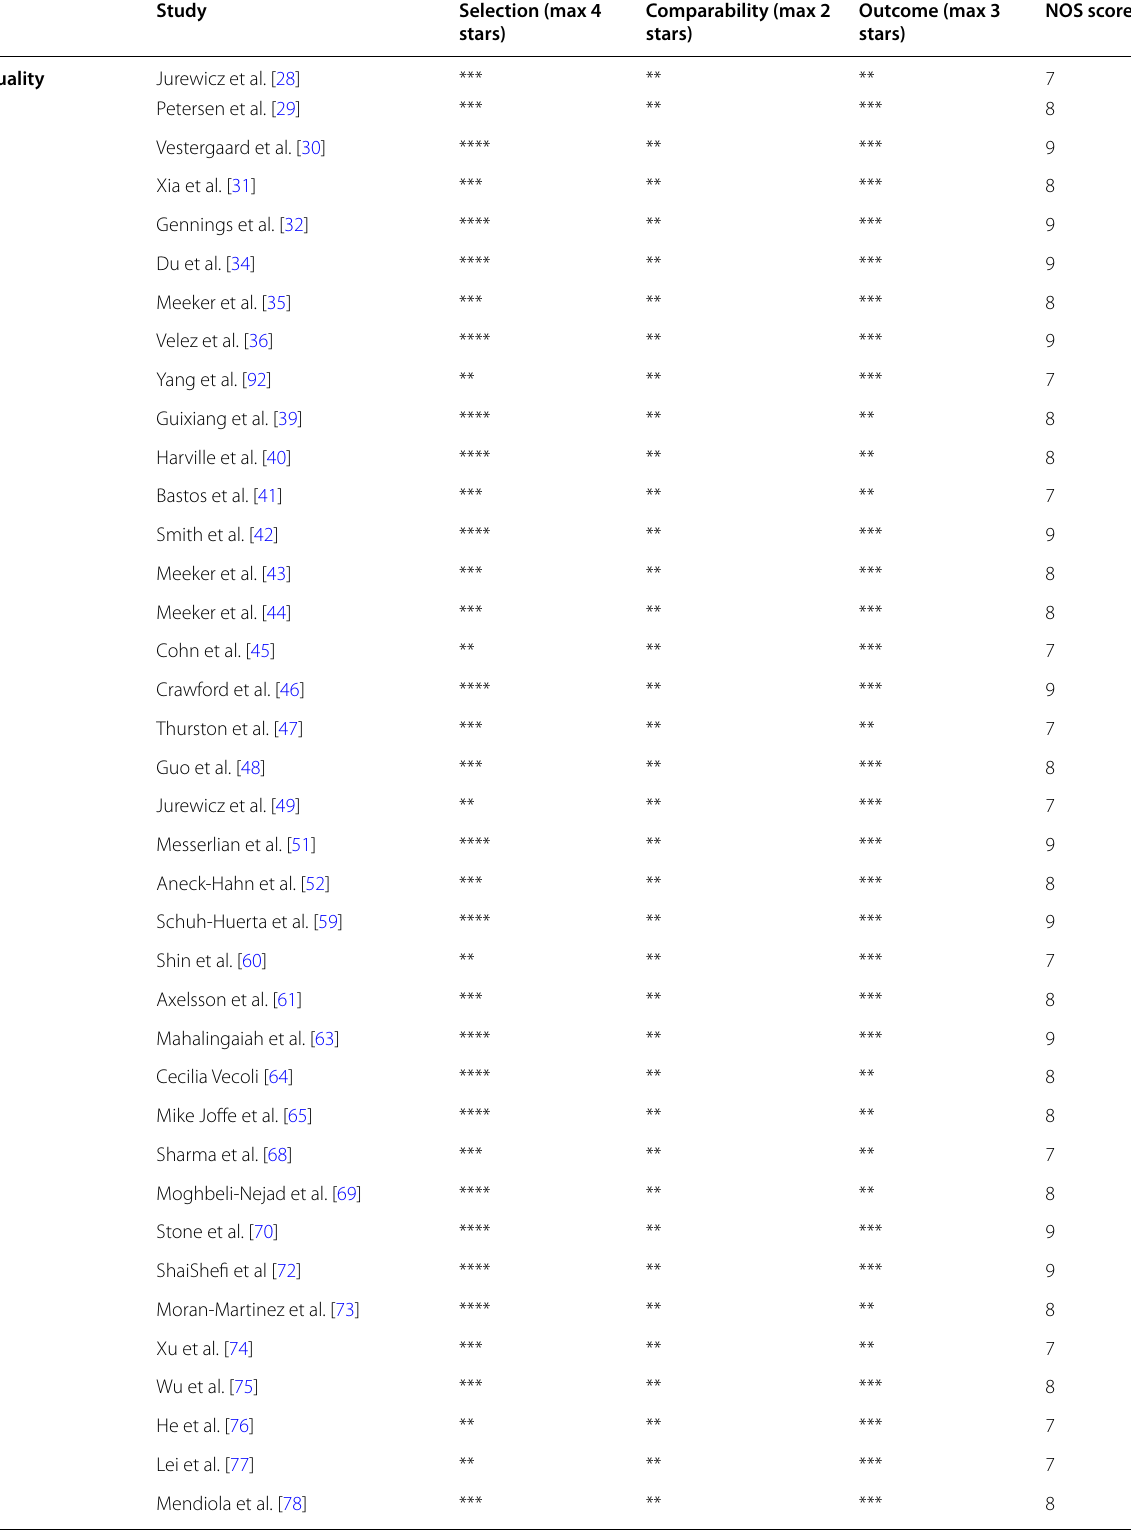
Table 4 Quality assessment of studies (cohort, case-control, and cross-sectional) (Newcastle and Ottawa checklist) Quality Good